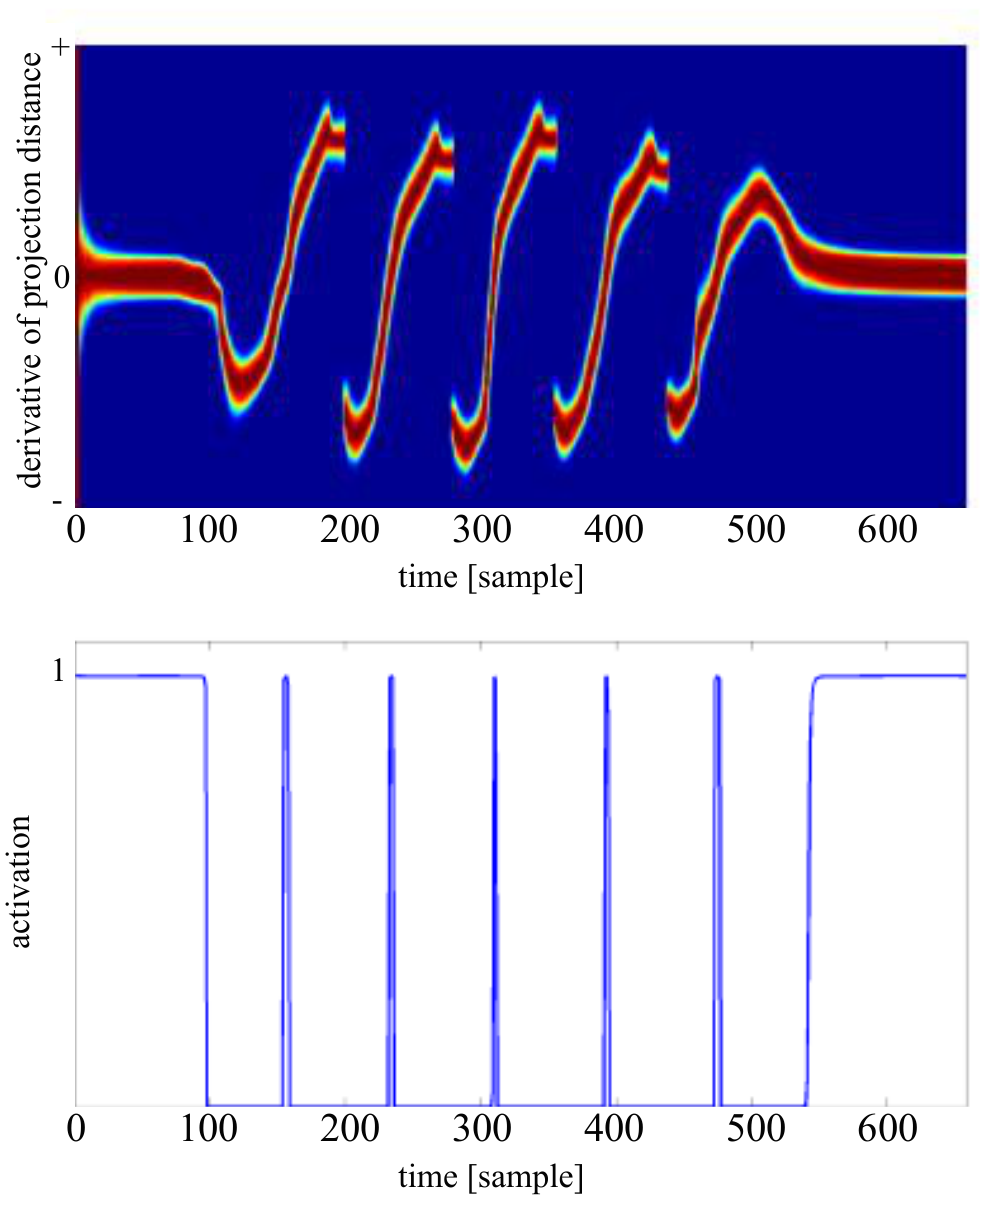
Figure 12. Example for a zero crossing sequence of interest. a) shows the input stimulus of the derivation from a pro- jected distance between right and left foot with respect to the x-y plane over time. b) The corresponding sequence of interest when using zero crossing